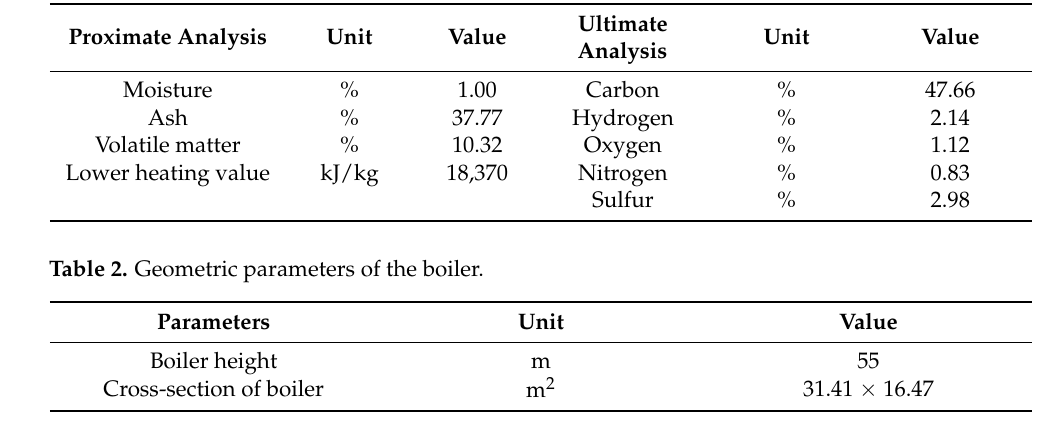
Table 1. Analysis of coal.